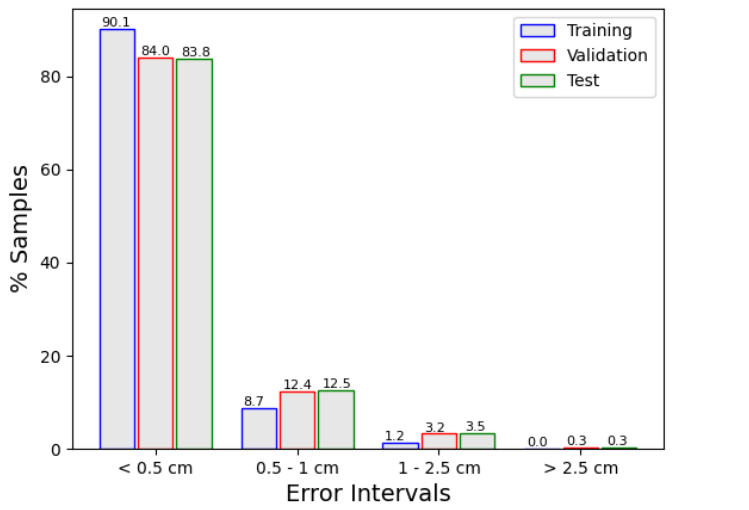
Figure 9. Percentage of predictions by error intervals for the height forecasting problem with the ensemble model 17.